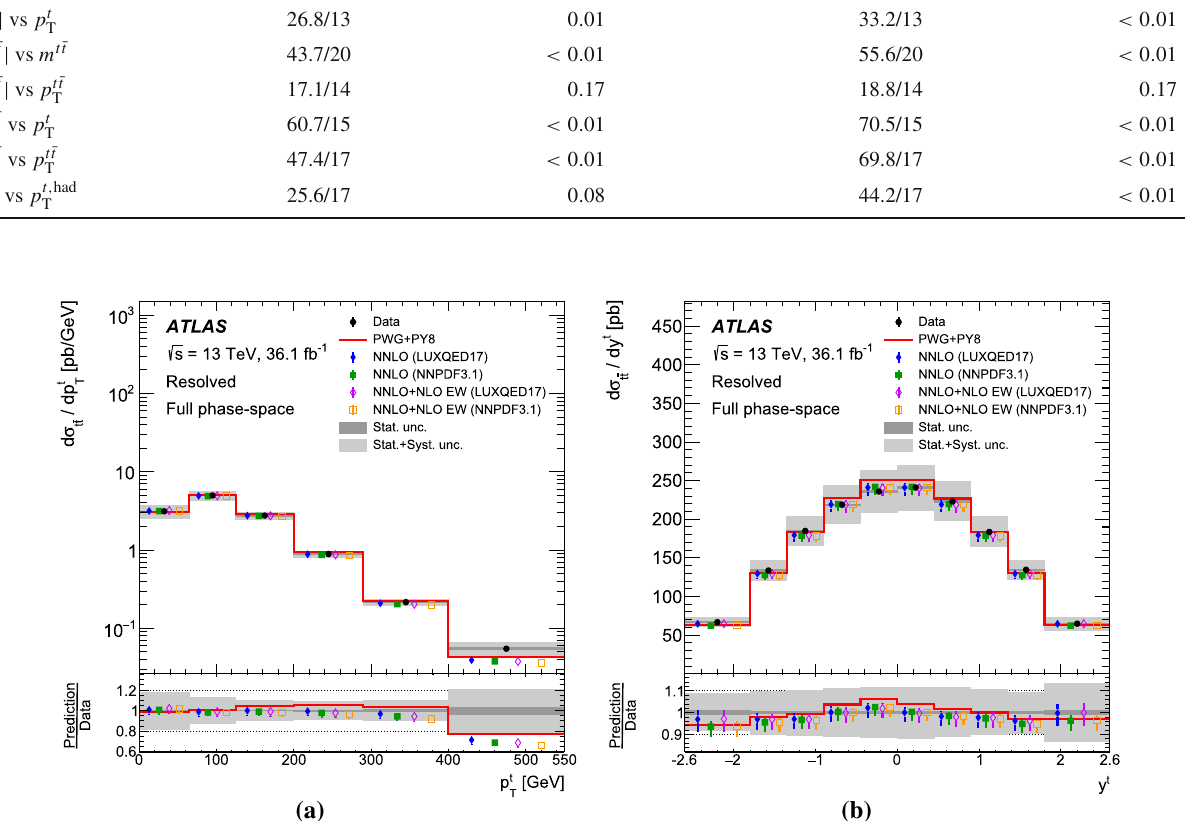
Fig. 64 Parton-level absolute differential cross-sections as a function of a p t and b y t in the resolved topology. The results are compared T with NNLO QCD and NNLO QCD+NLO EW theoretical calculations using the NNPDF3.1 and LUXQED17 PDF sets. The vertical bars on each marker represents the total uncertainty in the prediction. The solid